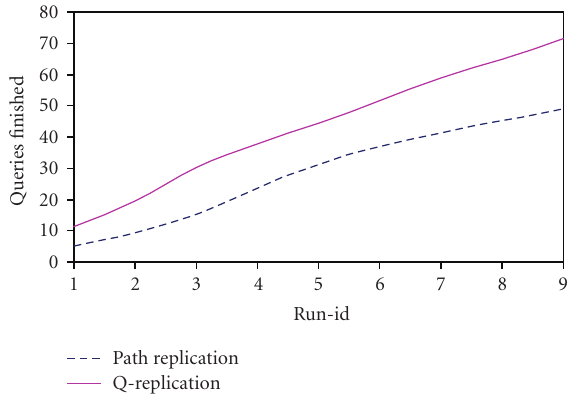
Figure 10: Percentage of queries